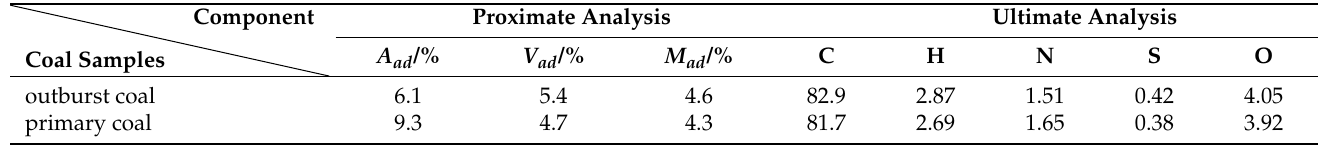
Table 1. Coal sample analysis